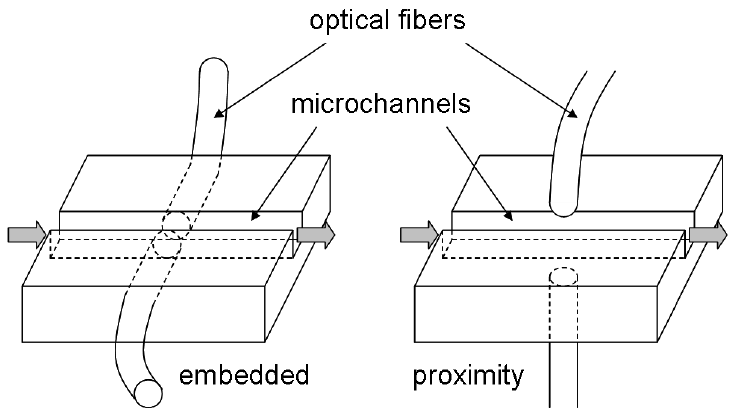
Figure 15. Embedded and proximity optical fibers for lab-on-a-chip. Reprinted from [47] with permission © American Society for Agricultural and Biological